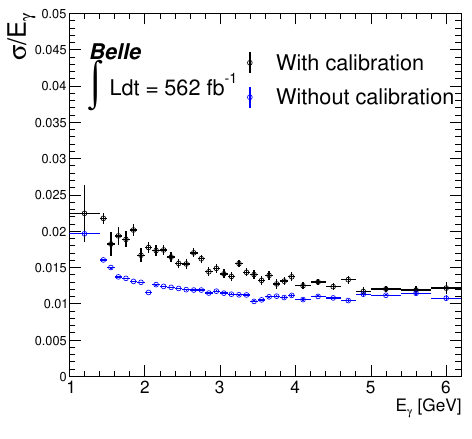
Figure 1 . Energy resolution as a function of the reconstructed photon energy in the e + e − → µ + µ − γ events. Black (Blue) points are the photon energy resolution with (without) the calibration applied. Error bars are the statistical